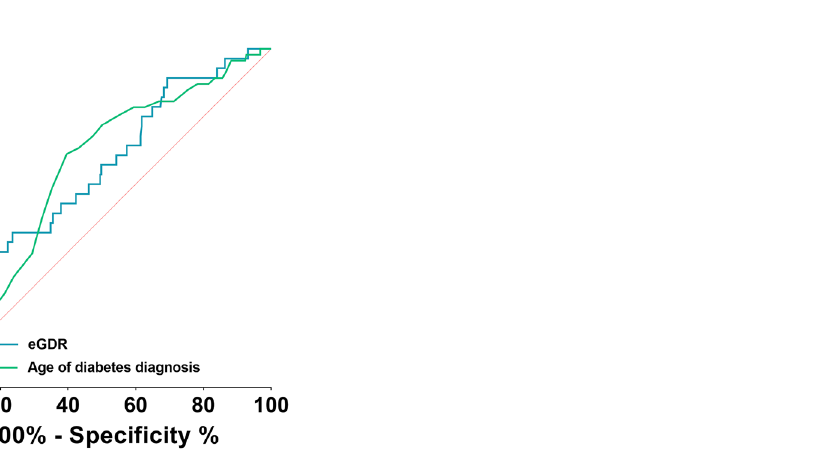
Figure 1. The receiver operating (ROC) curve of factors associated with LADA. eGDR, Estimated glucose disposal rate. The area under curve for eGDR and age of diabetes diagnosis are 0.674 and 0.632,